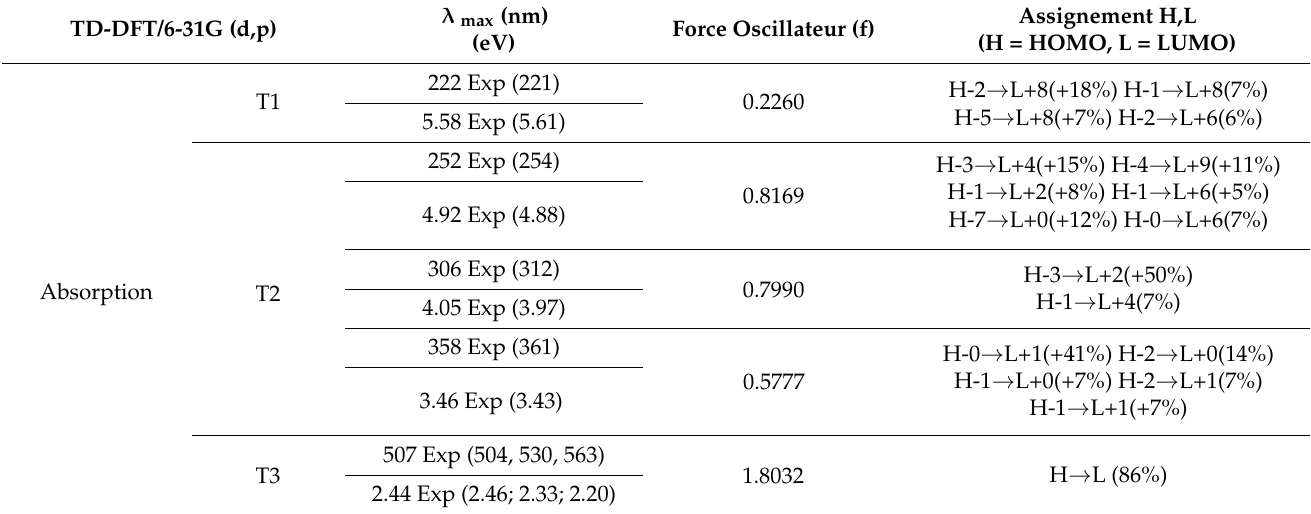
Table 1. Assignments of the electronic transitions of the